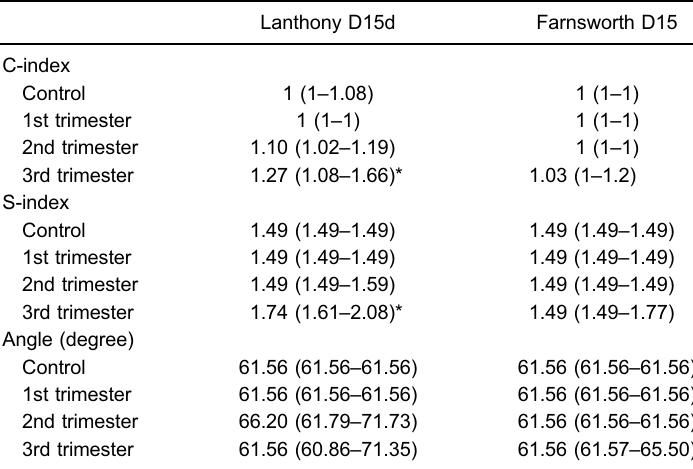
Table 1. Descriptive statistics of the hue ordering test results of fi rst to third- semester pregnant women and controls.